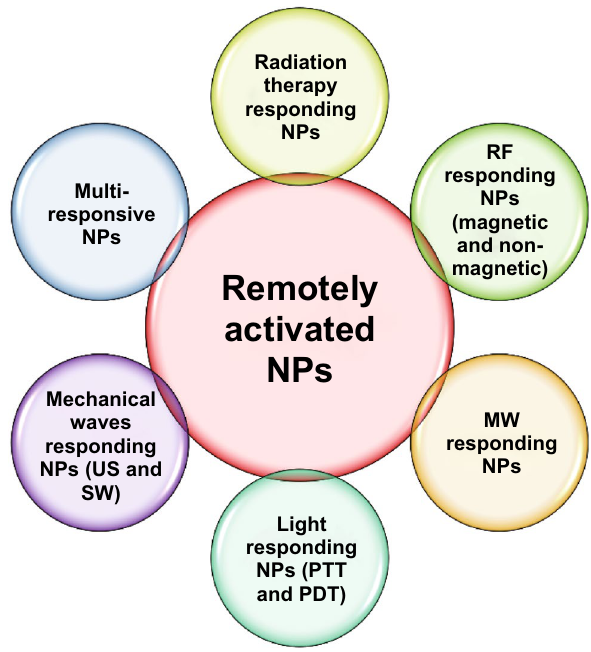
Fig. 1 Overview of remotely activated NPs presented in this review. Radiation therapy, radiofrequency (RF), microwave (MW), light as photothermal therapy (PTT) and photodynamic therapy (PDT), mechanical waves as ultrasound (US) and shock waves (SW) respond- ing NPs are presented, as well as NPs responsive to multiple simulta- neous